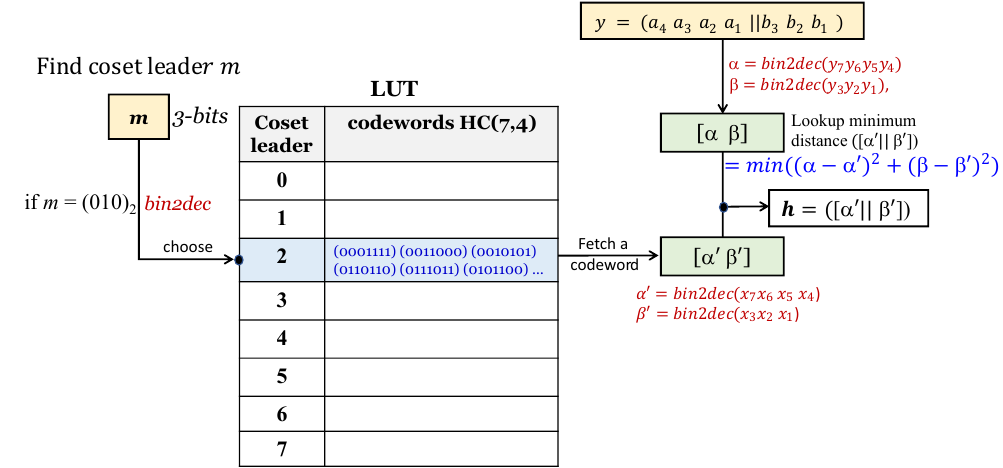
Figure 4. The flowchart of the lookup codeword with m . HC, Hamming